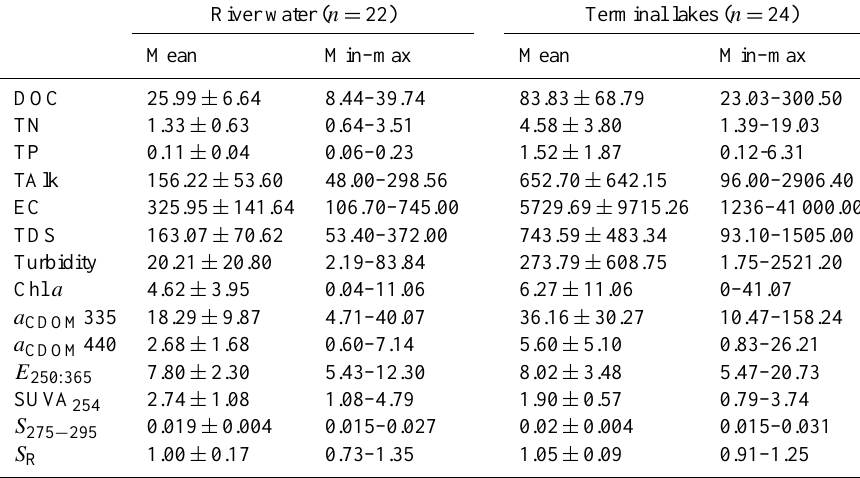
Table 1. Water quality and CDOM absorption parameters of water samples collected in the Hulun Buir plateau.